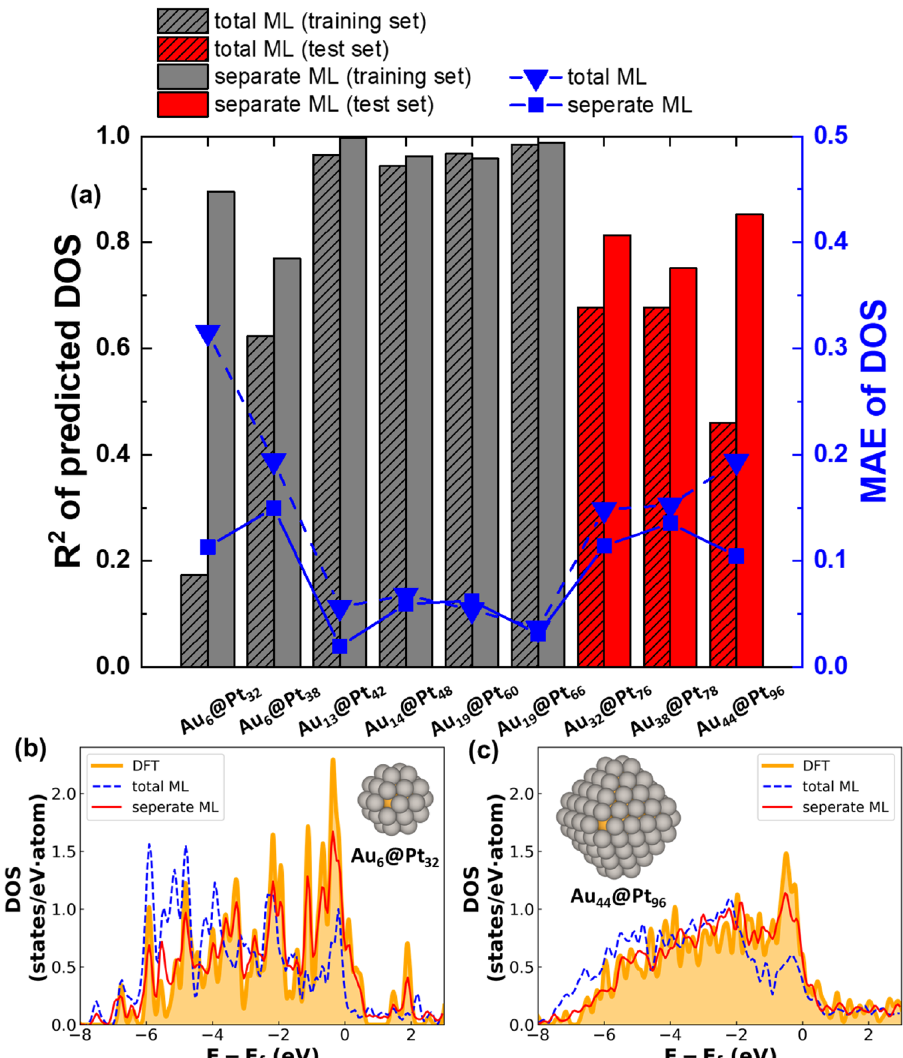
Figure 5. PCA-CGCNN performance on Au@Pt bimetallic NPs. ( a ) The DOS pattern similarity (R 2 and MAE) of our PCA-CGCNN model compared to DFT methods. Here, bimetallic Au@Pt NPs are considered. Bars indicate R 2 value and blue squares indicate MAE. ( b , c ) Comparison of DOS patterns for Au 6 @Pt 38 ( b ) and Au 32 @Pt 76 ( c ) NPs predicted by the DFT method (yellow) and the PCA-CGCNN model (blue = total learning and red = separate